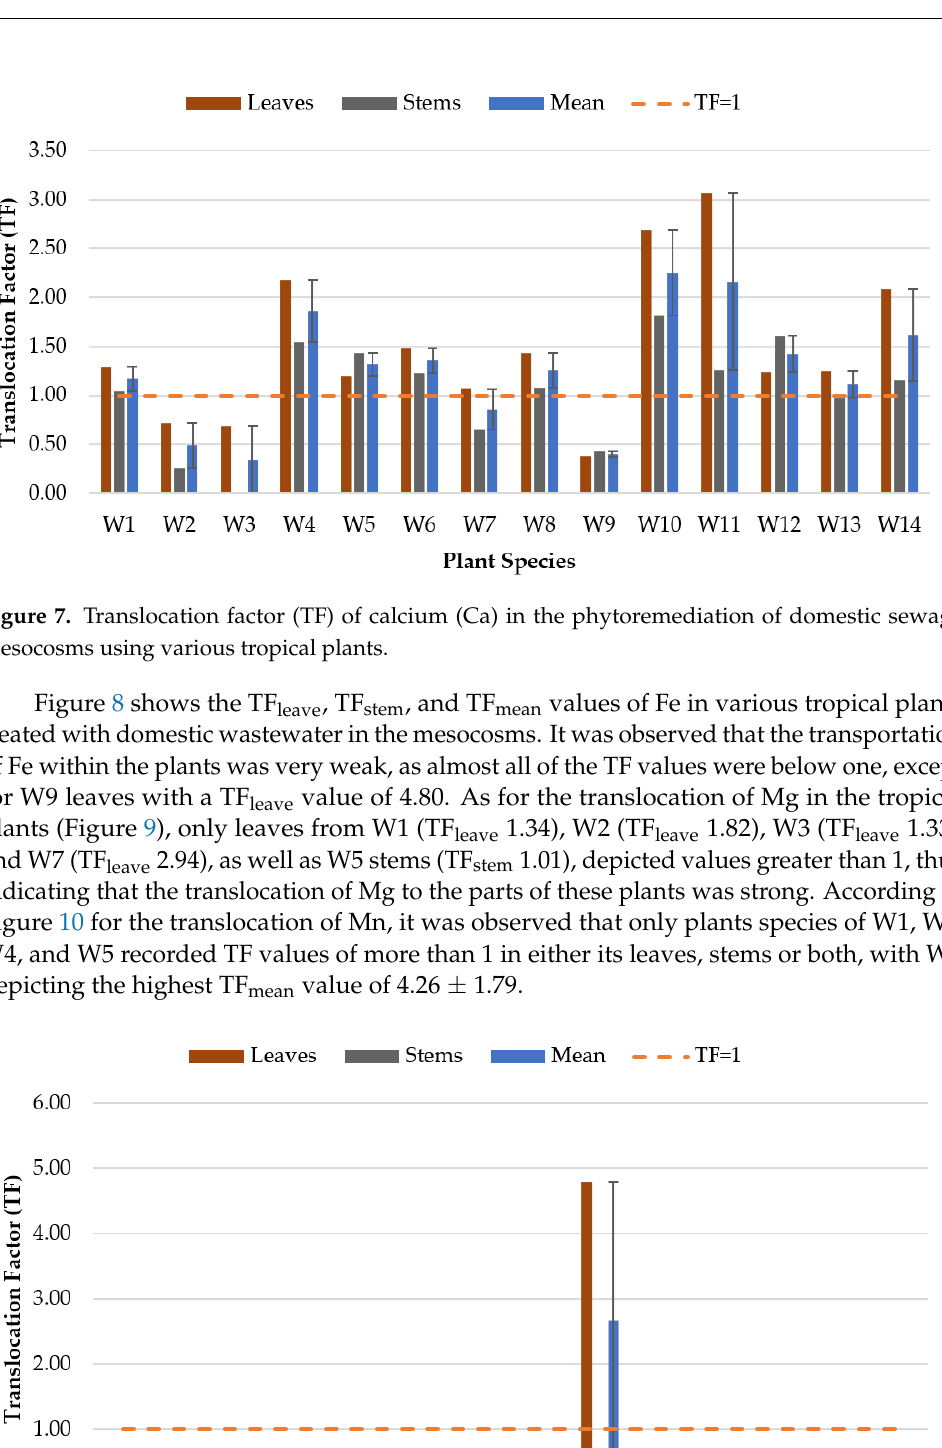
Figure 9. Translocation factor (TF) of magnesium (Mg) in the phytoremediation of domestic sewage mesocosms using various tropical plants.